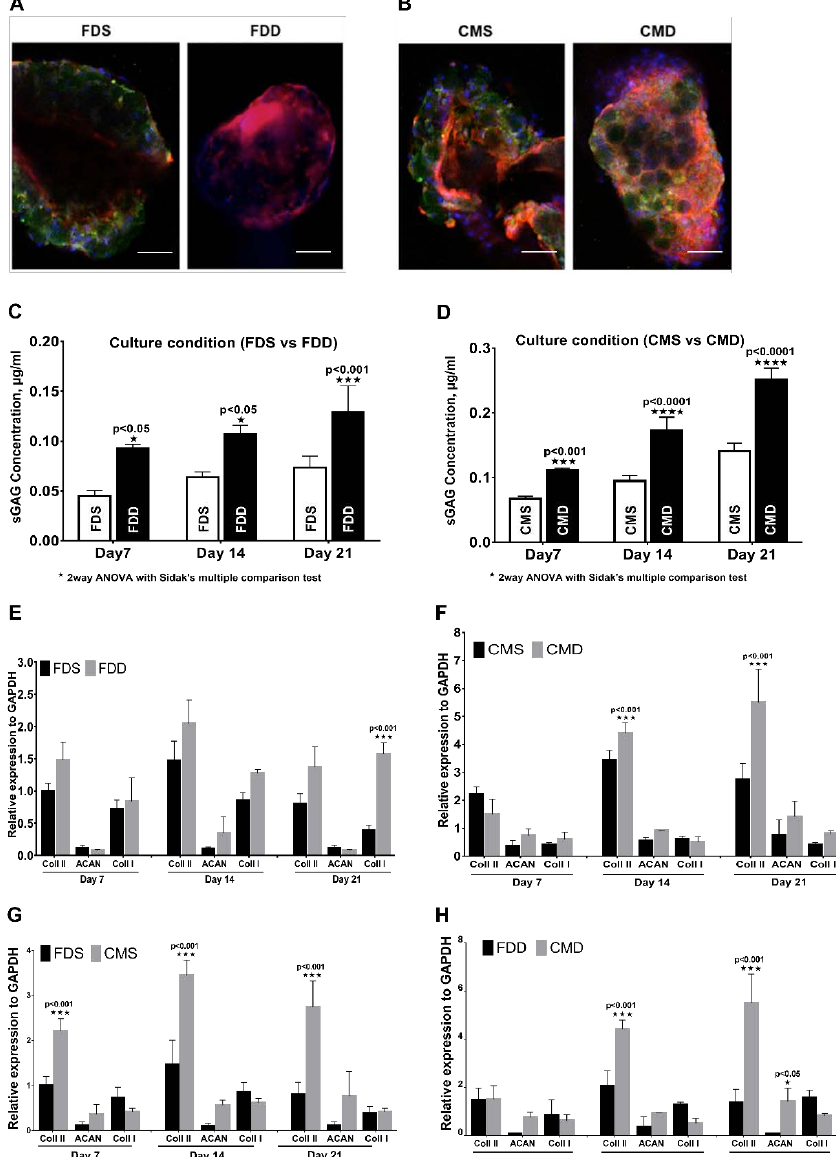
Figure 5. Chondrogenic differentiation of BMSCs in the static and dynamic cultural environment. Evaluation based on the different medium and culture system. ( A , B ) Immunohistochemistry staining with rabbit anti-human collagen II and counterstained with 4′,6 -diamidino-2-phenylindole ( DAPI) on day 21, (100 × Magnification; scale bar: 100 µ m). ( C , D ) Proteoglycan expression and ( E – H ) RNA expression of BMSCs on GM in FDD, FDS, CMD, and CMS. All experiments based on BMSCs-GM were incubated in FD and CIM for 7, 14, and 21 days using static and dynamic culture condition in FD and CIM mediums. Figure 4. BMSC attachment and proliferation in the static and dynamic culture system. Evaluation based on the different medium and culture system. ( A , B ) A macroscopic view and proliferation of BMSCs-GM in FDS and FDD culture condition. ( C , D ) A macroscopic view and proliferation of BMSCs-GM in CMS and CMD culture condition. ( E , F ) A macroscopic view of BMSCs-GM in FDD, FDS, CMD, and CMS. All experiments based on BMSCs-GM incubated in FD and CIM for 7, 14, and 21 days using static and dynamic culture condition (FD-Static (FDS), CIM-Static (CMS), FD-Dynamic (FDD), and CIM-Dynamic (CMD)). The sample size ( n ) for each experiment was six ( n = 6). (Figure 4E: 100 × magnification; scale bar: 100 µ m. Figure 4F: 3000 × Magnification; scale bar: 40 µ m). (FD-Static (FDS), CIM-Static (CMS), FD-Dynamic (FDD), CIM-Dynamic (CMD)). ( p ≤ 0.001: FDS vs. FDD, CMS vs. CMD, FDS vs. CMS and FDD vs.